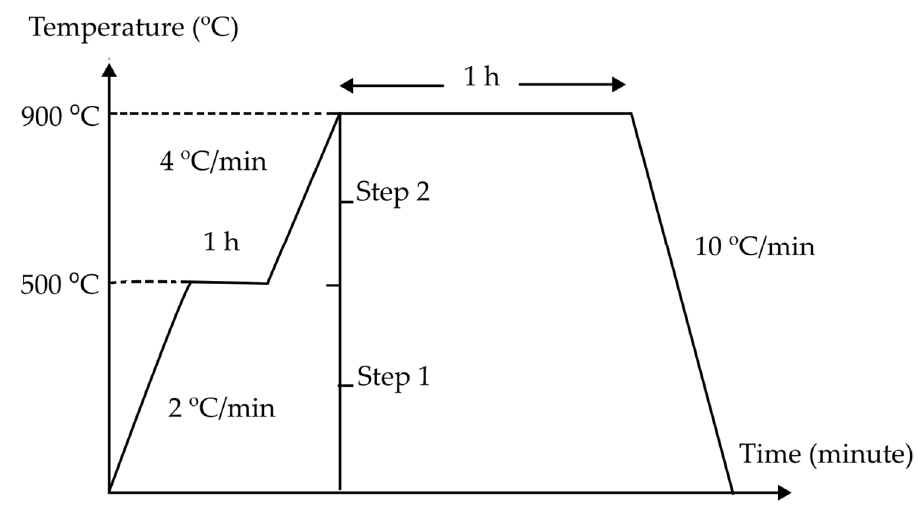
Figure 1. Two-steps sintering profile of kaolin-GGBS geopolymer [22]. Ma et al. [46] revealed that the flexural strength SiC whiskers (SCWS) reinforced geopolymer composites (SCWS/KGP) composites could be improved with the presence of SiC whisker and reached the peak value when the SCWS content was 2 wt%. The production process for the composite of SiC whiskers (SCWS) and KGP (Kaolin Geopolymer) is shown in Figure 2. The improvement in the KGP composites’ flexural strength is mostly attributable to the strong interface bonding between the SiC whiskers and the geopolymer matrix. When its content reached 4 wt%, whiskers aggregation was observed, which negatively impacted the mechanical performance of SCWS/KGP composites. Additionally, geopolymer evolved into high density, twin-structure leucite ceramics after being heated to 1100 ◦ C and 1200 ◦ C. While this was going on, there was no interfacial reaction between the leucite matrix and the SiC whisker, which preserved its chemical stability. Due to leucite formation and a strong interfacial contact between the whisker and matrix, the composite treated at 1200 ◦ C with 2 wt% SiC whisker demonstrated a 124.8% higher flexural strength than the composites before high temperature treatment. Nevertheless, this research does not compute the compressive strength, which is the interfacial zone between the whisker and the matrix, because shrinkage can be determined by the whisker that is subjected to compressive stresses.